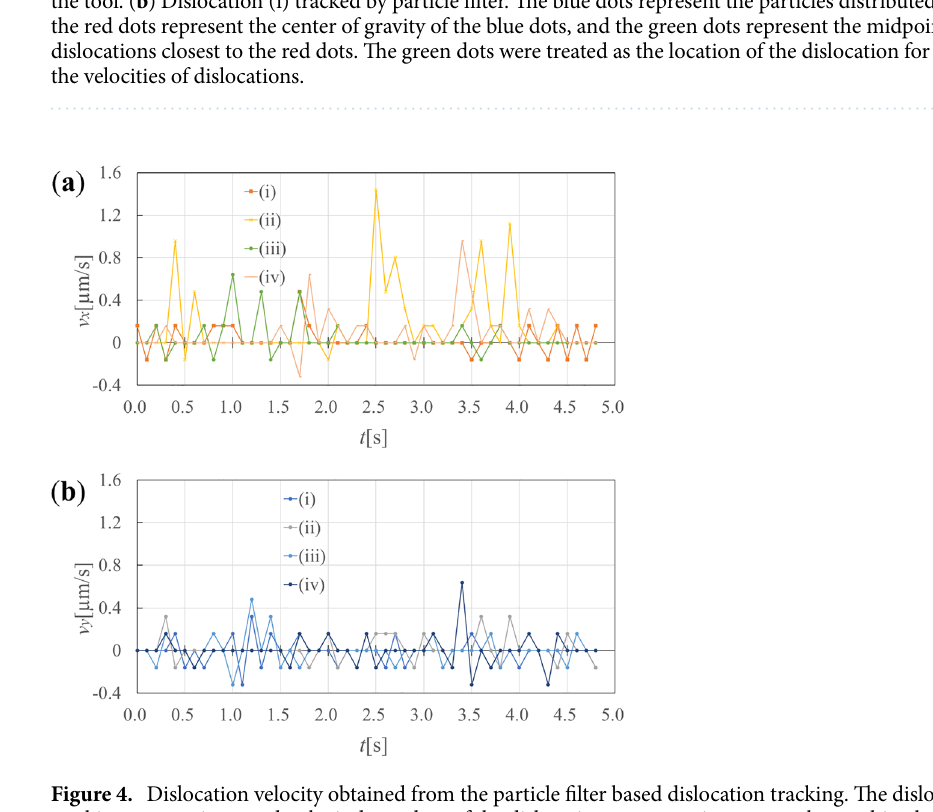
Figure 4. Dislocation velocity obtained from the particle filter based dislocation tracking. The dislocation tracking process is treated to be independent of the dislocation segmentation process by machine learning. ( a ) Velocity in x direction. The dislocations moved intermittently between 0–1.6 µm. ( b ) Velocity in y